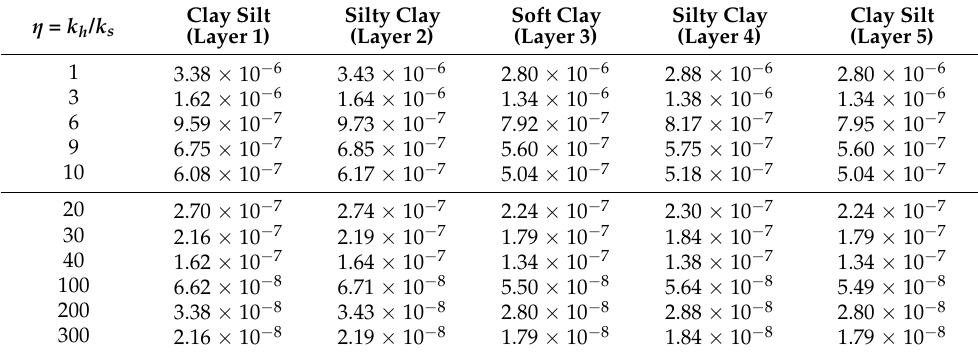
Table 3. An equivalent horizontal permeability in m/day.